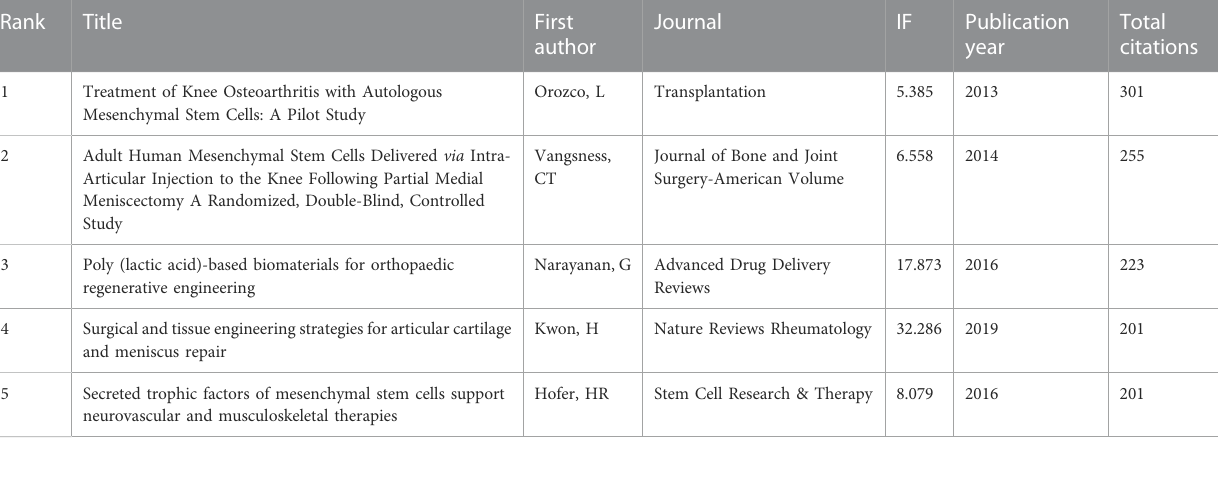
TABLE 4 The top 10 most productive journals related to stem cells for meniscal regeneration.